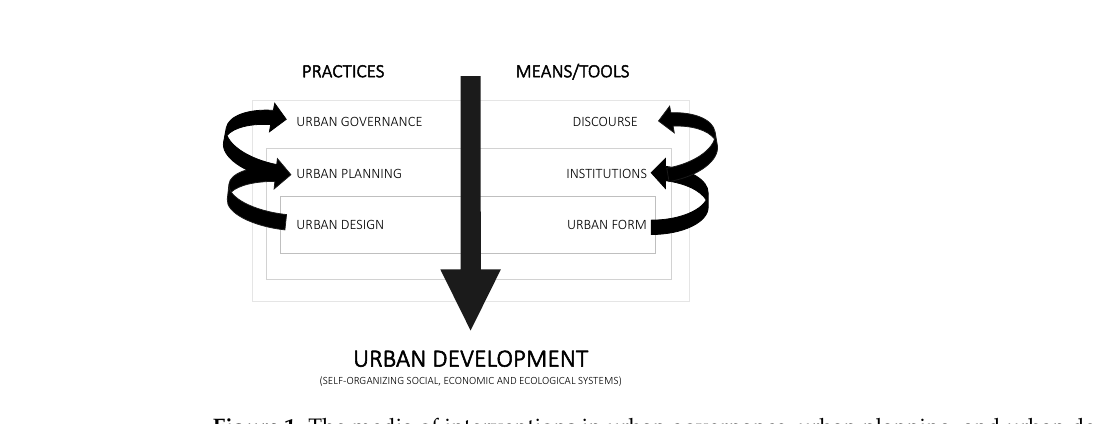
Figure 1. The media of interventions in urban governance, urban planning, and urban design.